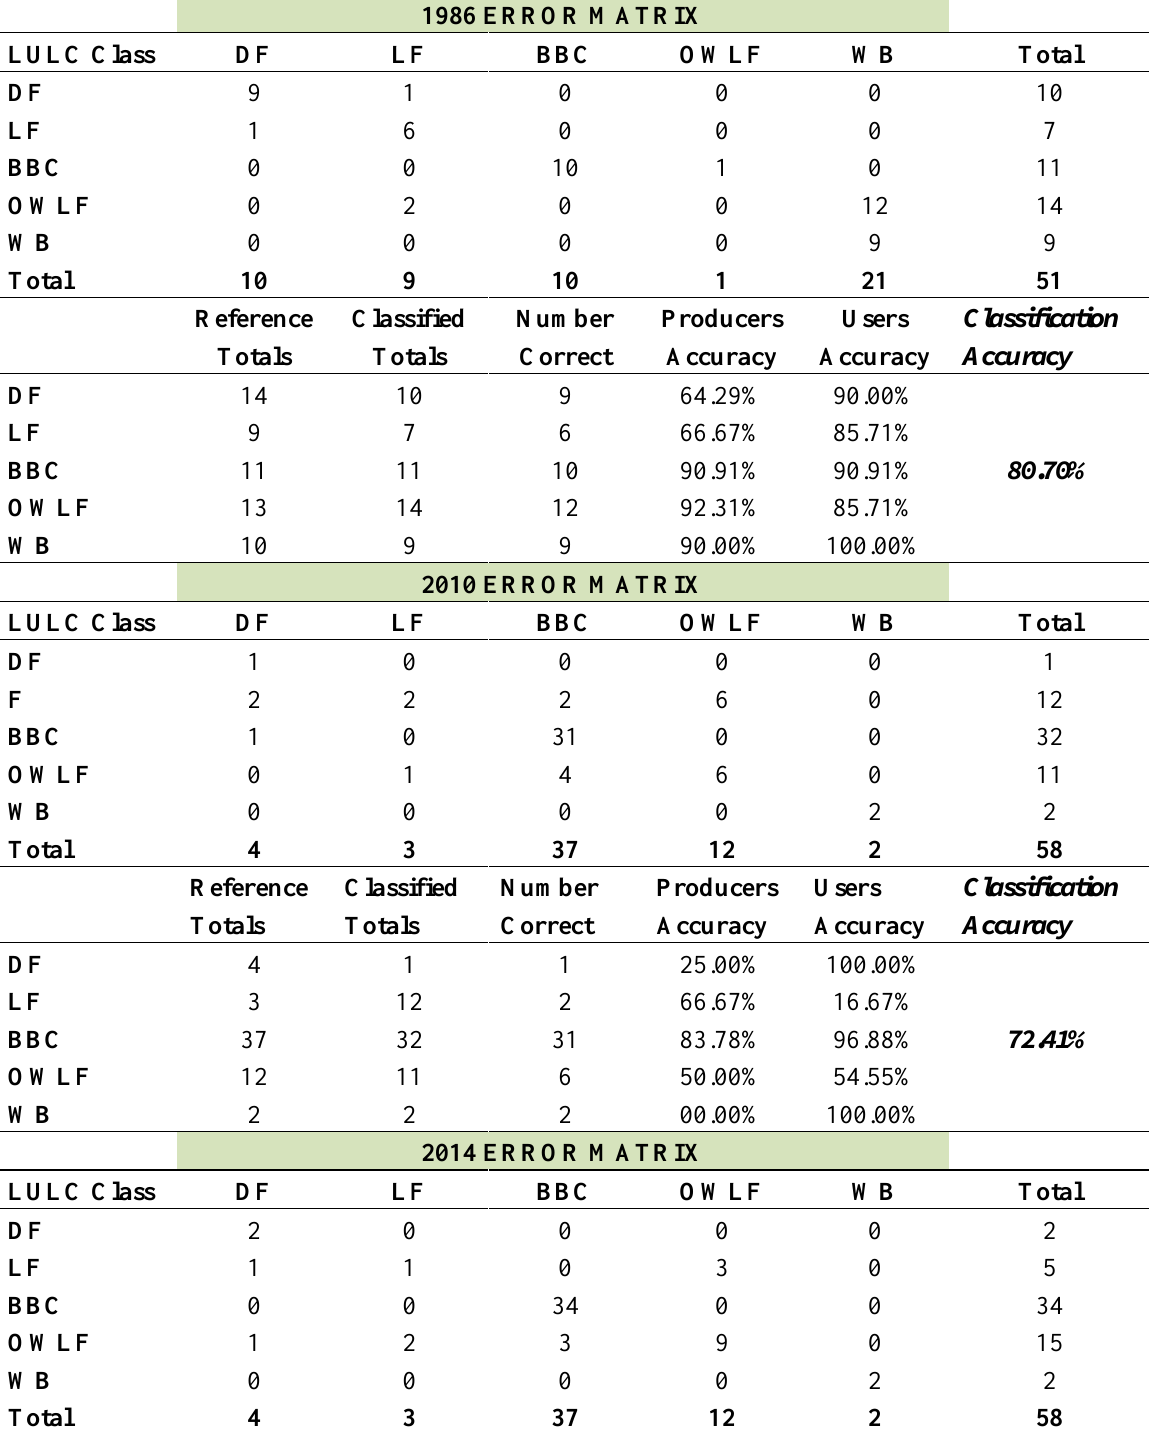
Table 1. Classification contingency matrix for 1986, 2010 & 2014